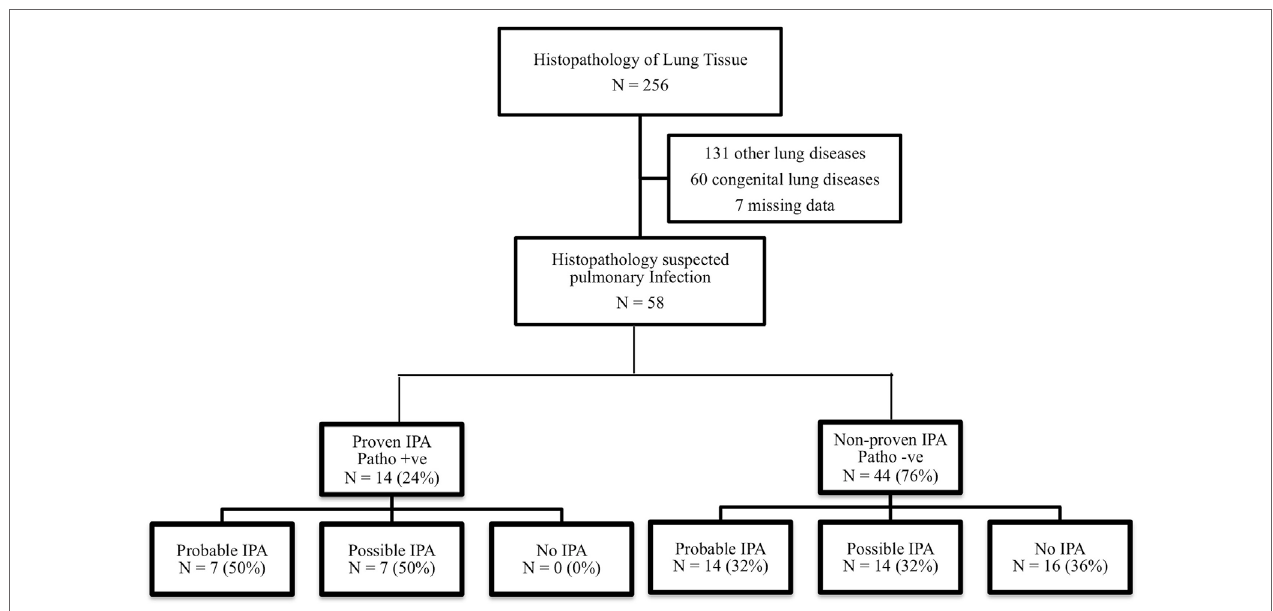
FigUre 1 | Flow diagram and classification of invasive pulmonary aspergillosis (IPA) according to the EORTC/MSG 2008 consensus